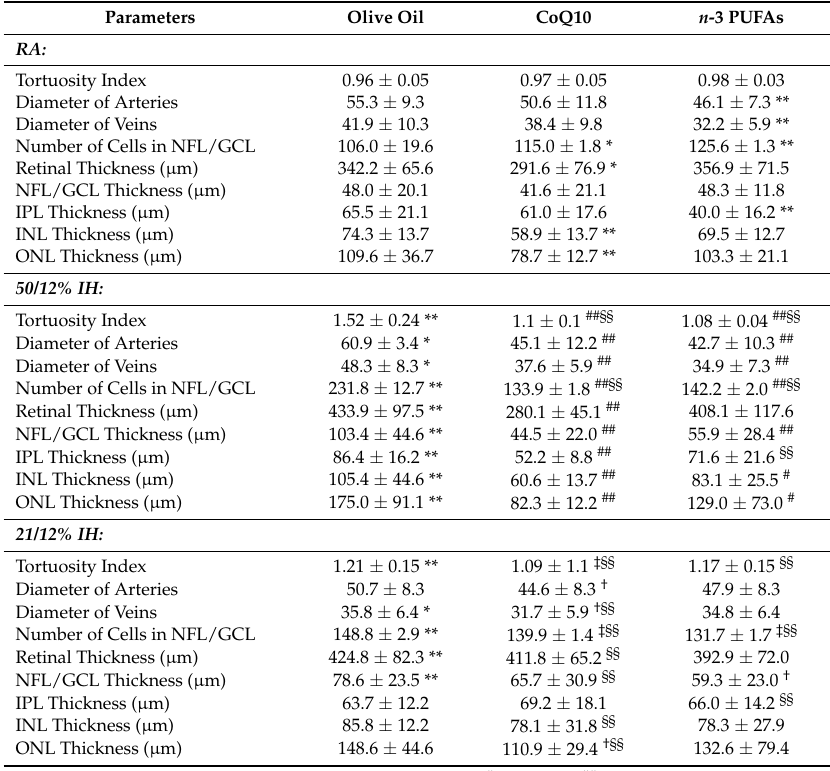
Data are mean ± SD (* p < 0.05, ** p < 0.01 vs. olive oil in RA; # p < 0.05; ## p < 0.01 vs. olive oil in 50/12% O 2 IH; † p < 0.05 vs. olive oil in 21/12% O 2 ; and §§ p < 0.01 vs. RA). n = 24 measurements/group; RA (room air); IH (intermittent hypoxia); NFL/GCL (nerve fiber layer/ganglion cell layer); IPL (inner plexiform layer); INL (inner nuclear layer); ONL (outer nuclear